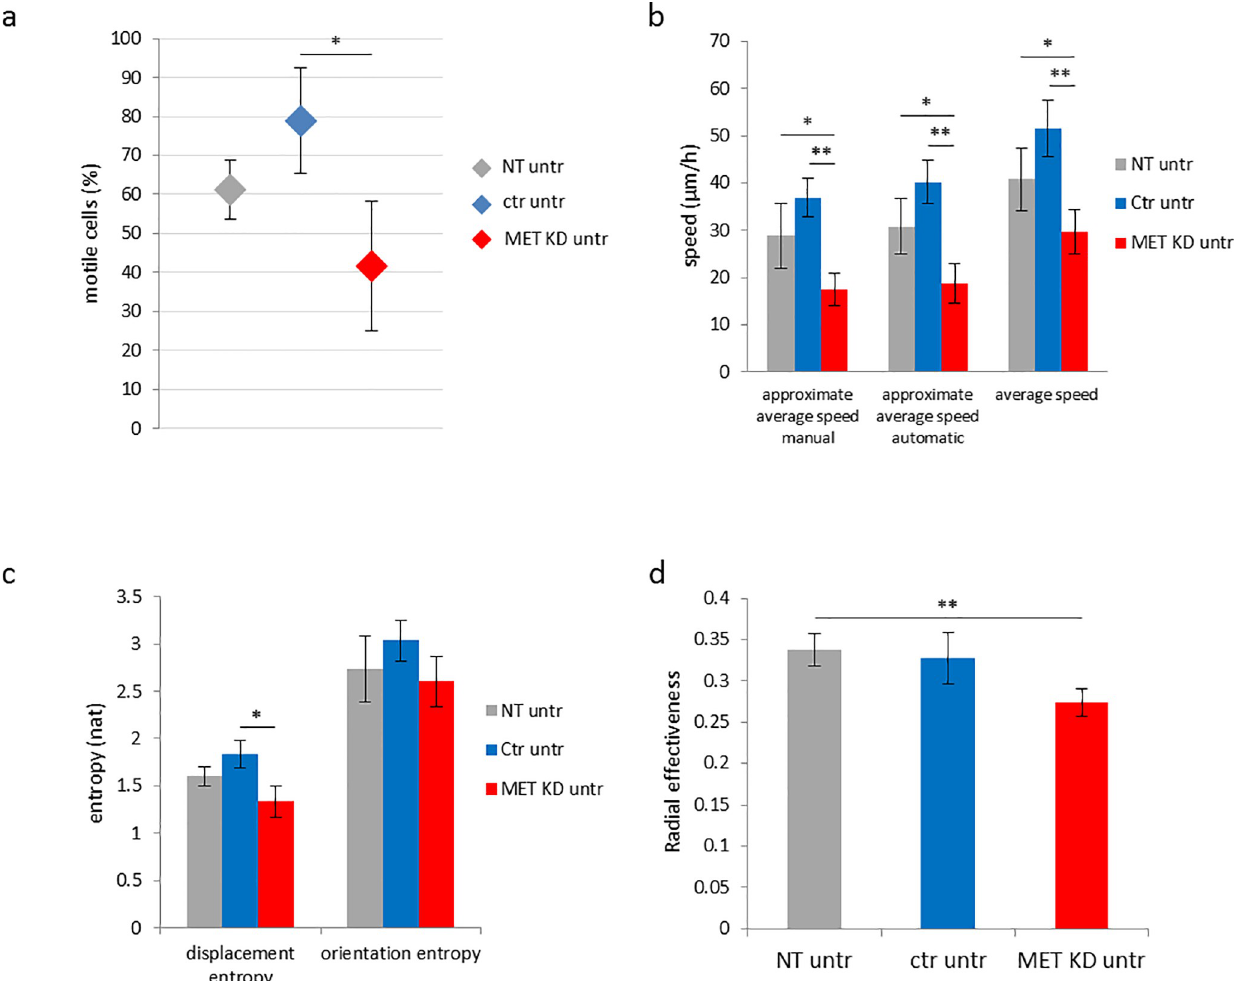
Fig 8. MET knockdown decreases cell motility, speed, displacement entropy and radial effectiveness. Hs746T cells were transfected with MET siRNA (MET KD) or control siRNA (Ctr). Non-transfected cells (NT) were analyzed as control. Time-lapse microscopy was started one day after transfection. Cell movement was tracked for 7 hours to assess motility (a), average speed (b), entropy (c) and radial effectiveness (d). The mean of three to four biological experiments with standard deviation is shown. T-test was used to compare NT, MET KD and Ctr cells. Statistically significant differences are indicated by � p < 0.05 or �� p <